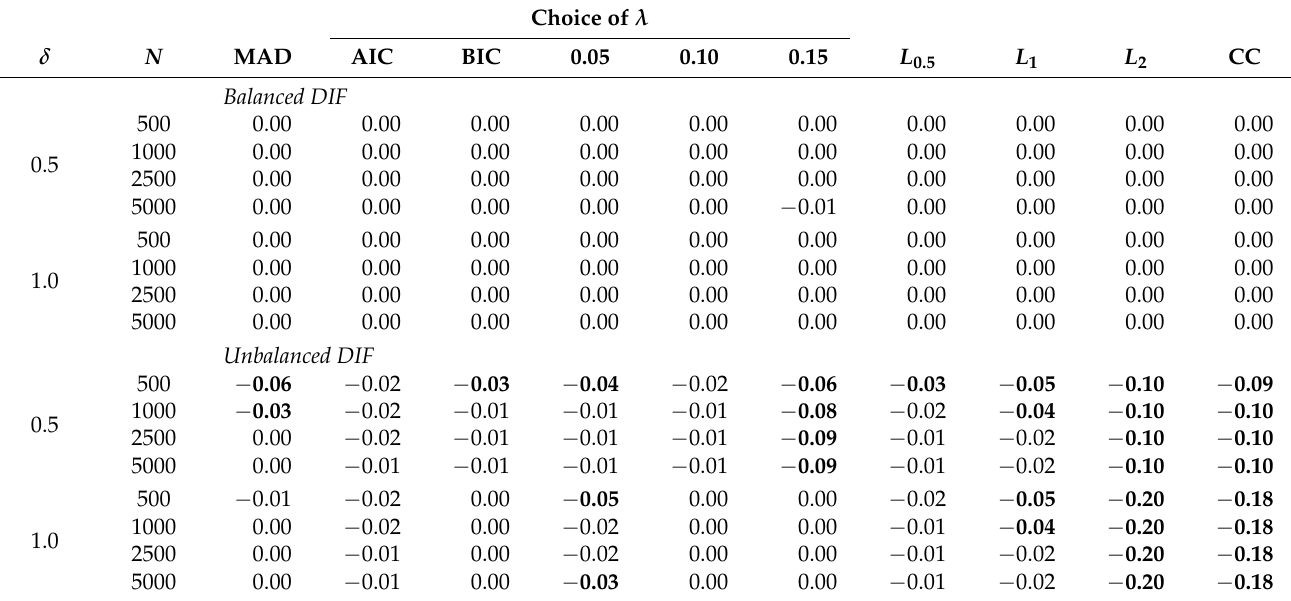
Table 1. Simulation Study 1: Bias of estimated group means for balanced and unbalanced DIF effects as a function of the size of DIF effects δ and sample size N . Choice of